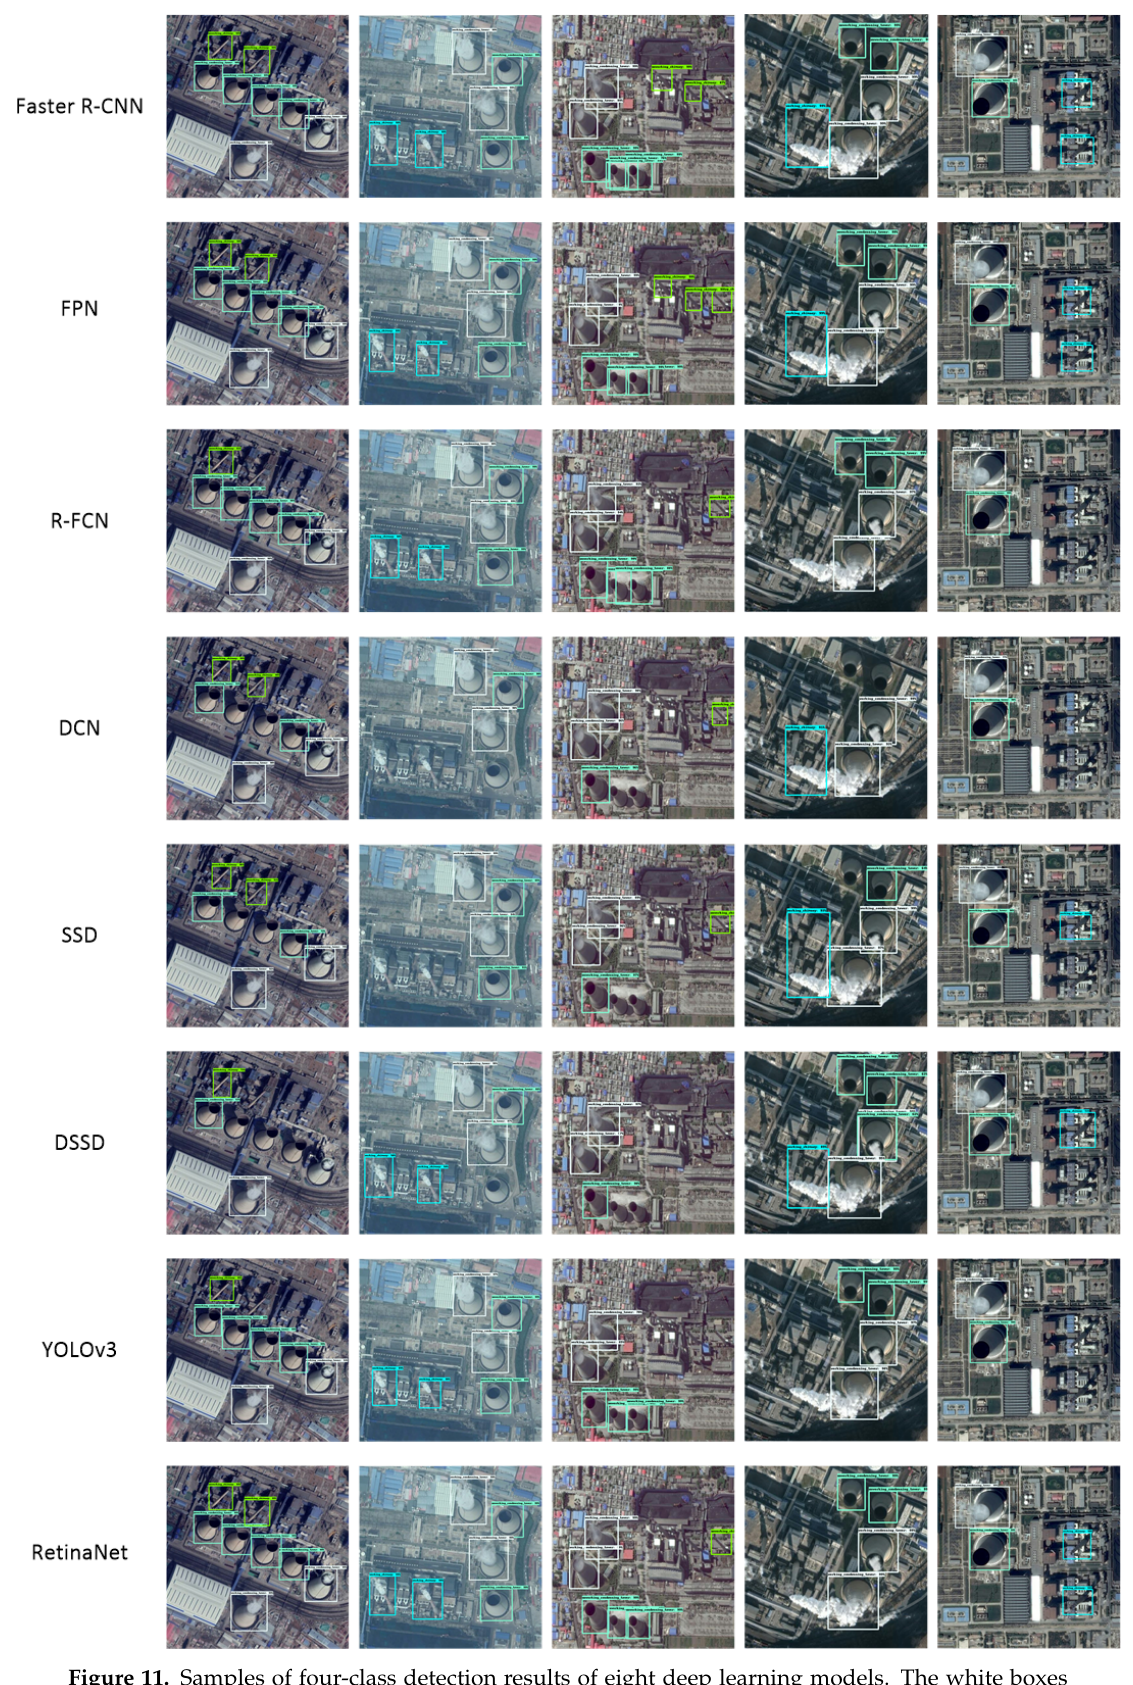
Figure 11. Samples of four-class detection results of eight deep learning models. The white boxes represent working condensing tower, the light blue boxes represent non-working condensing tower, the blue boxes represent working chimney, and the green boxes represent non-working